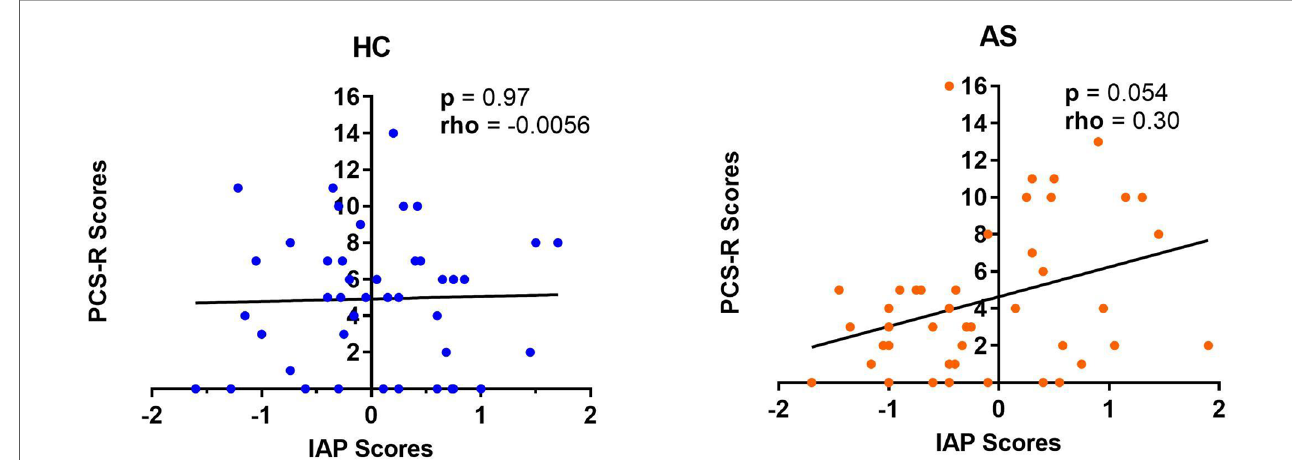
FIGURE 5 Relationship between intrinsic attention to pain (IAP) and pain rumination. The IAP scores were not signi fi cantly correlated with the pain rumination scores (derived from the rumination subscale of the pain catastrophizing scale) (PCS-R) in healthy controls (HCs) (left panel) but there was a marginally signi fi cant positive correlation between the IAP scores and the PCS-R scores in the ankylosing spondylitis (AS) group (right panel). The HCs are represented by the blue dots. The AS group is represented by the orange dots.